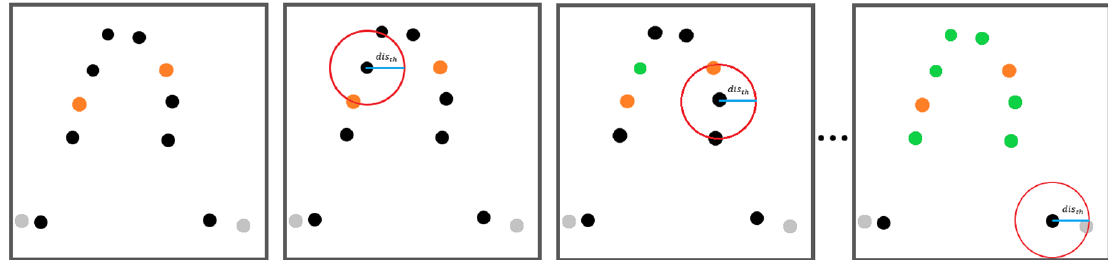
Figure 4. Fine extraction iteration schematic. Orange points represent the points derived from coarse extraction; black points represent the points in S u ; green points represent tree points derived from the fine extraction; and the gray points are the points in the original data that are not involved in the operation. As a result of the iteration, the orange and green points together form the tree points.